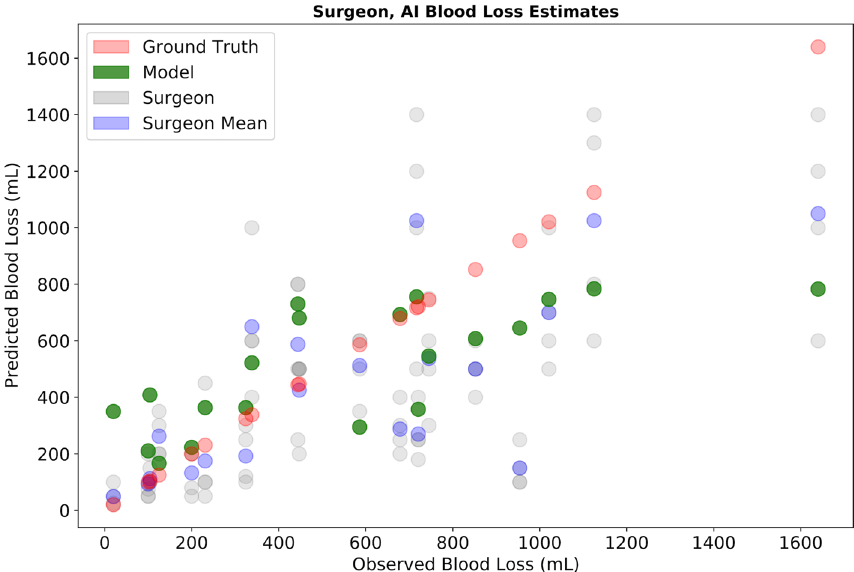
Figure 3. Expert and SOCALNet blood loss quantification. Predicted versus observed blood loss estimations by individual surgeons (grey), surgeon mean (blue), and model (green). Red points represent measured blood loss (ground